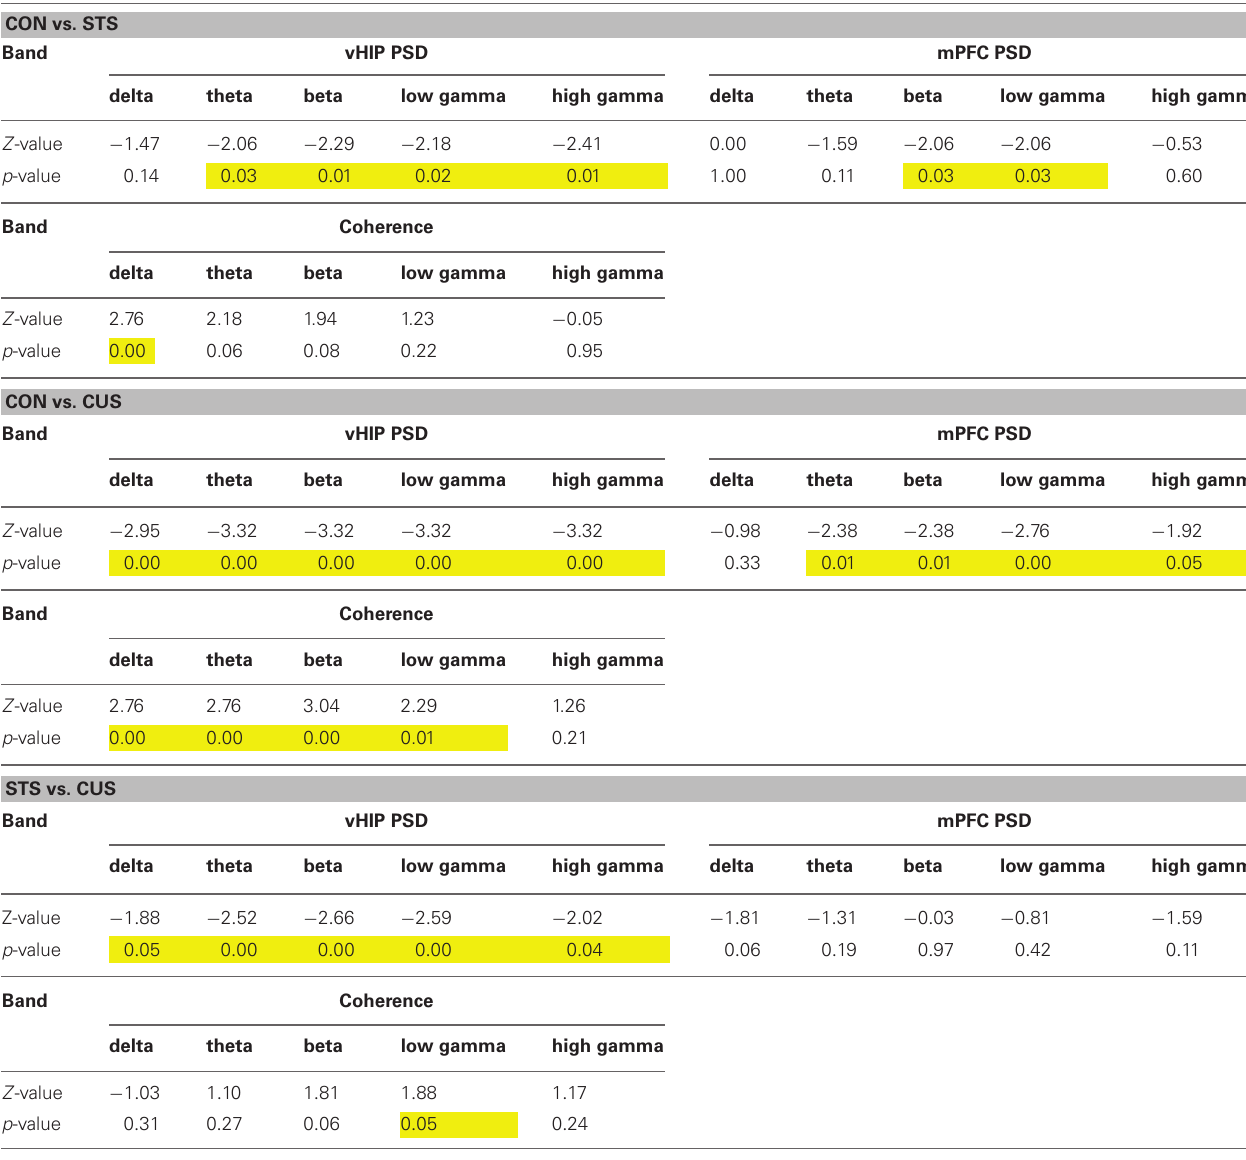
Each table represents the Z- and p-values of pairwise comparisons of vHIP PSD, mPFC PSD, and coherence values in the control (CON), short-term stress (STS), and chronic unpredictable stress (CUS) groups. These values correspond to the graphs presented in Figures 1 and 2 . Comparisons made by Mann–Whitney test; statistical significance is highlighted in yellow (p ≤